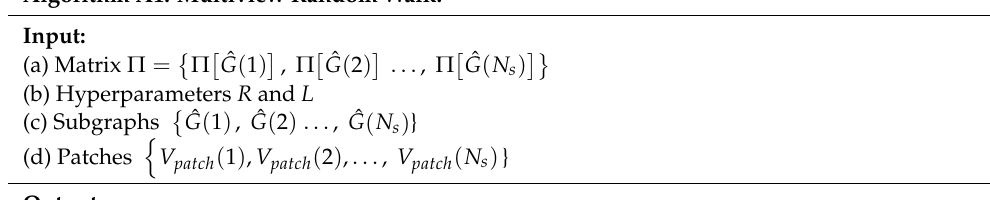
Algorithm A1: Multiview Random